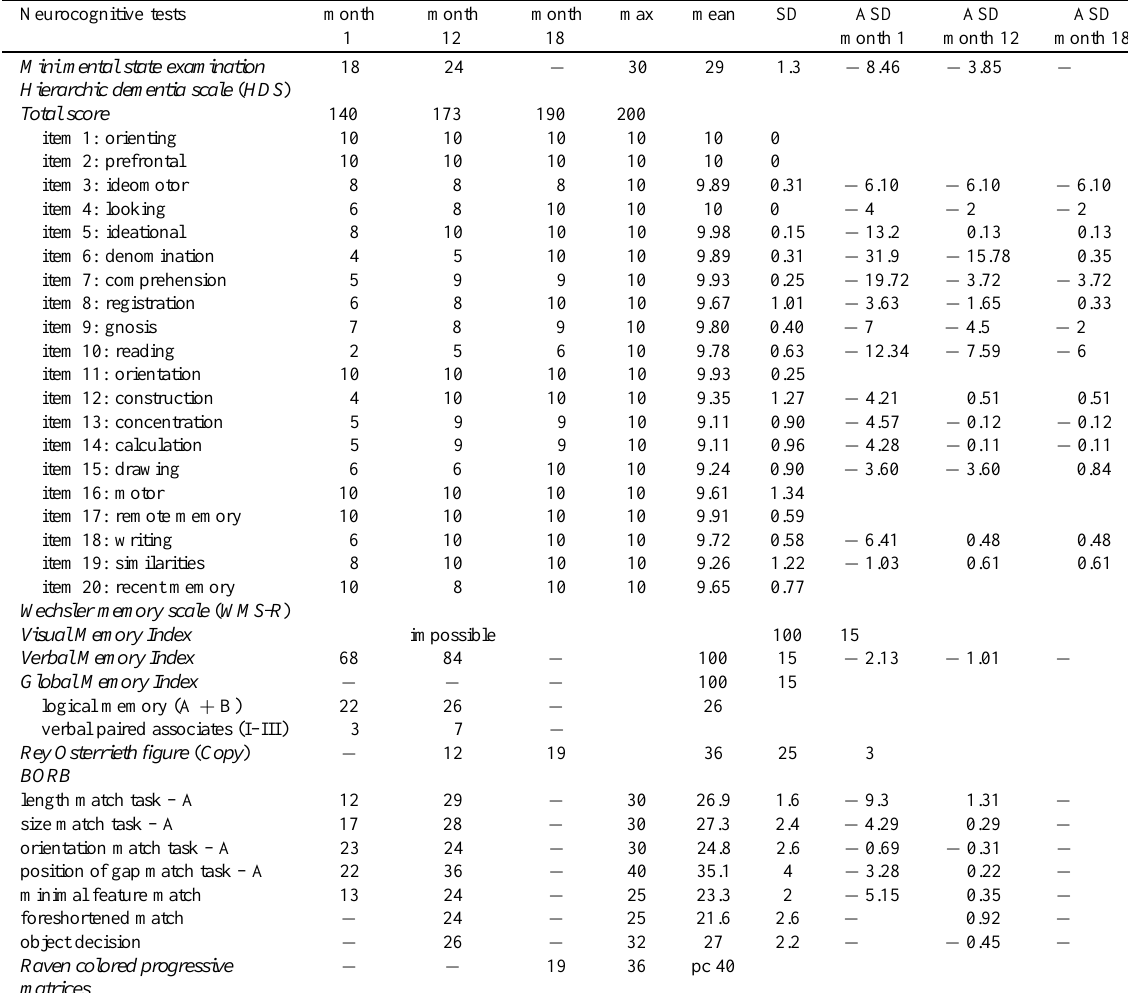
Table 2 Neurocognitive test results in the lesion and late phase of the